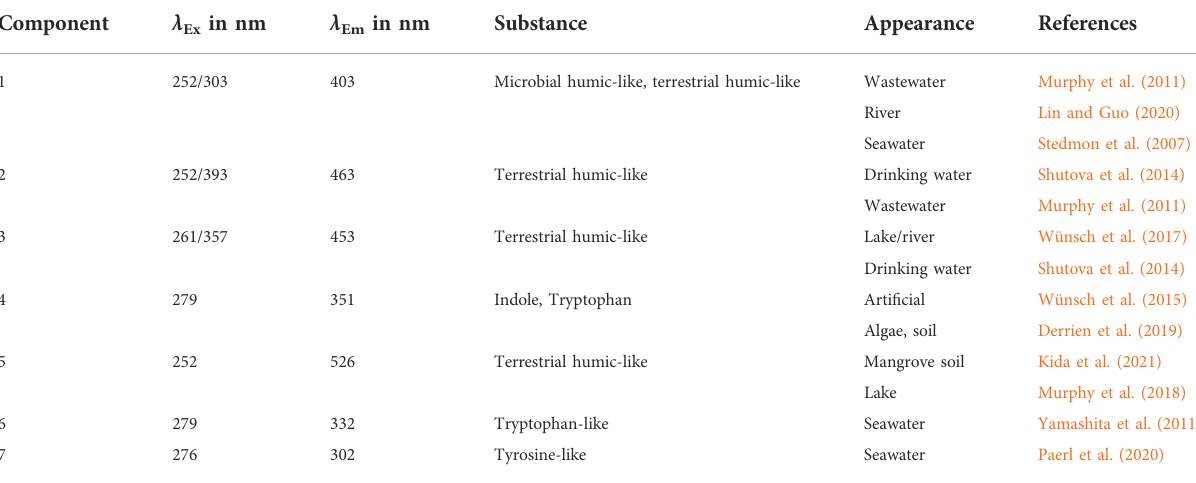
TABLE 2 Overview of seven components detected by the PARAFAC model in the present study, with their respective substance or substance-like designations, appearance in natural sources, and respective references according to Murphy et al. (2014).